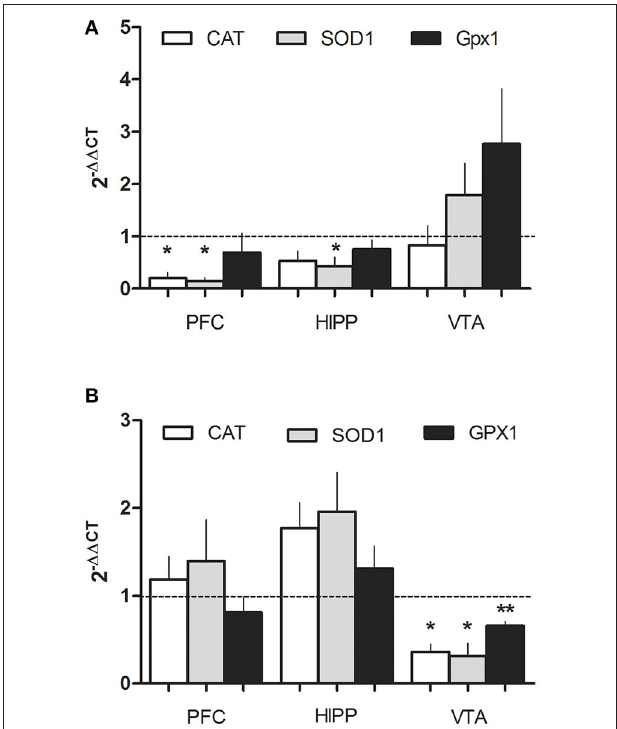
FIGURE 2 | PEE modifies the expression of antioxidant enzyme mRNAs in rat brain. Total RNA was obtained as detailed in the methods section from the Prefrontal cortex, (PFC), Hippocampus (HIPP), and Ventral tegmental area (VTA) from control or PEE rats of 21 (P21) (A) or 70 (P70) (B) days old and amplified using RT-qPCR. Data are expressed as a fold change between PEE vs. control gene expression. N = 3–5 litters. * P < 0.05, ** P < 0.01 (paired Student’s t -test compared with 1).